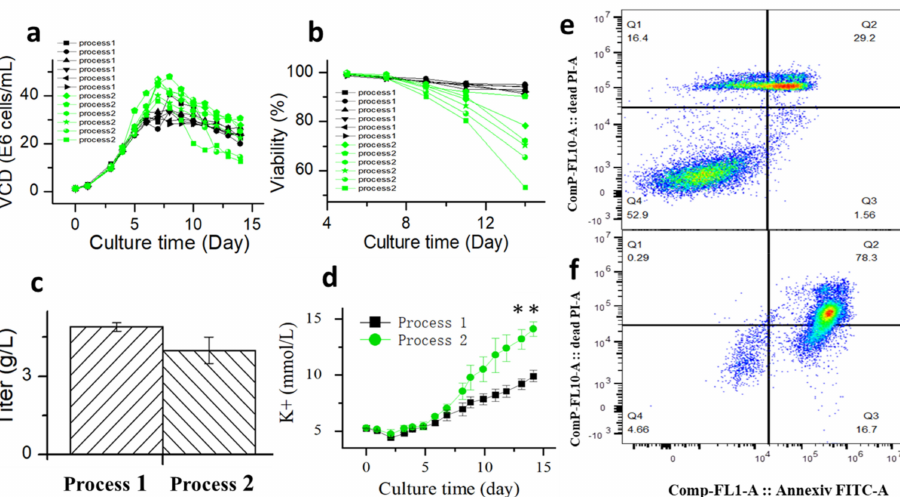
Figure 10. Comparison of viable cell density ( a ), cell viability ( b ), titer ( c ), extracellular potassium concentration ( d ), cell apoptosis on D14 of process 1 ( e ) and cell apoptosis on D14 of process 2 ( f ) based on Annexin V marker. Data are expressed as mean ± standard error of six replicates. ** p <